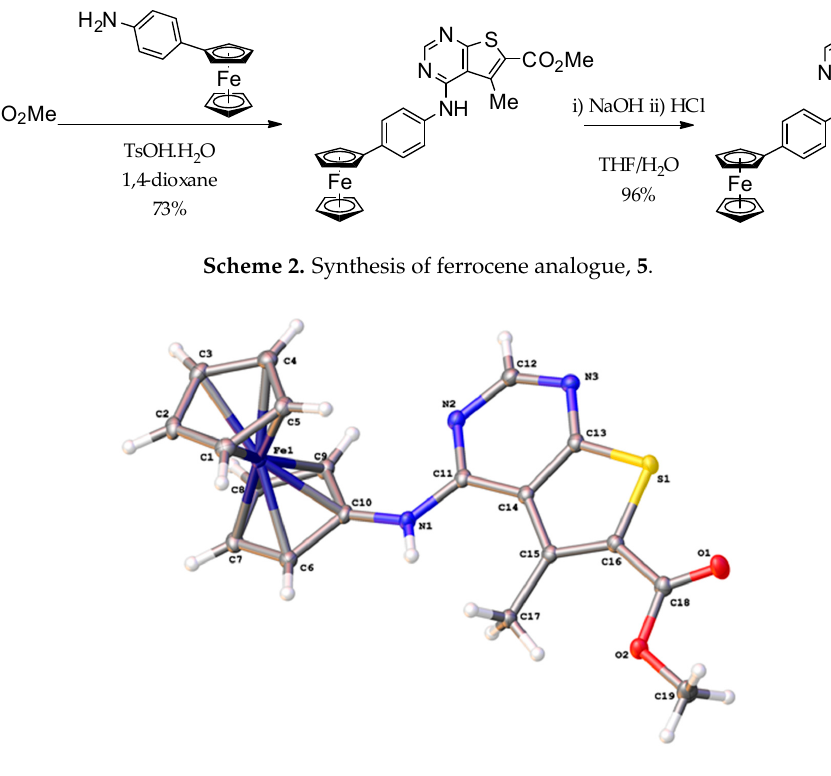
Figure 4. Crystal structure of compound 3 (CCDC 1862154).